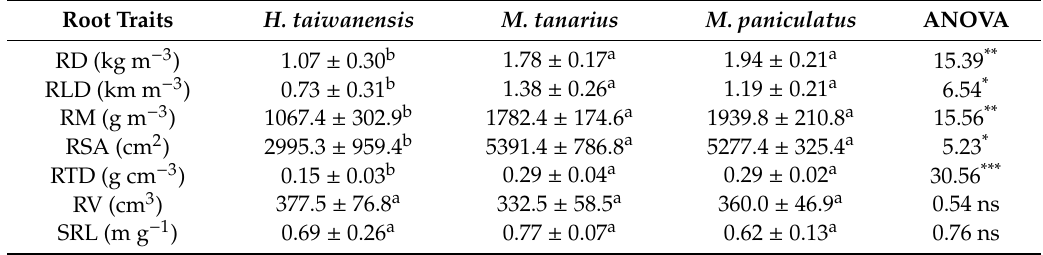
Table 4. Means ± standard deviations for root traits of the three species studied and F-values for one-way